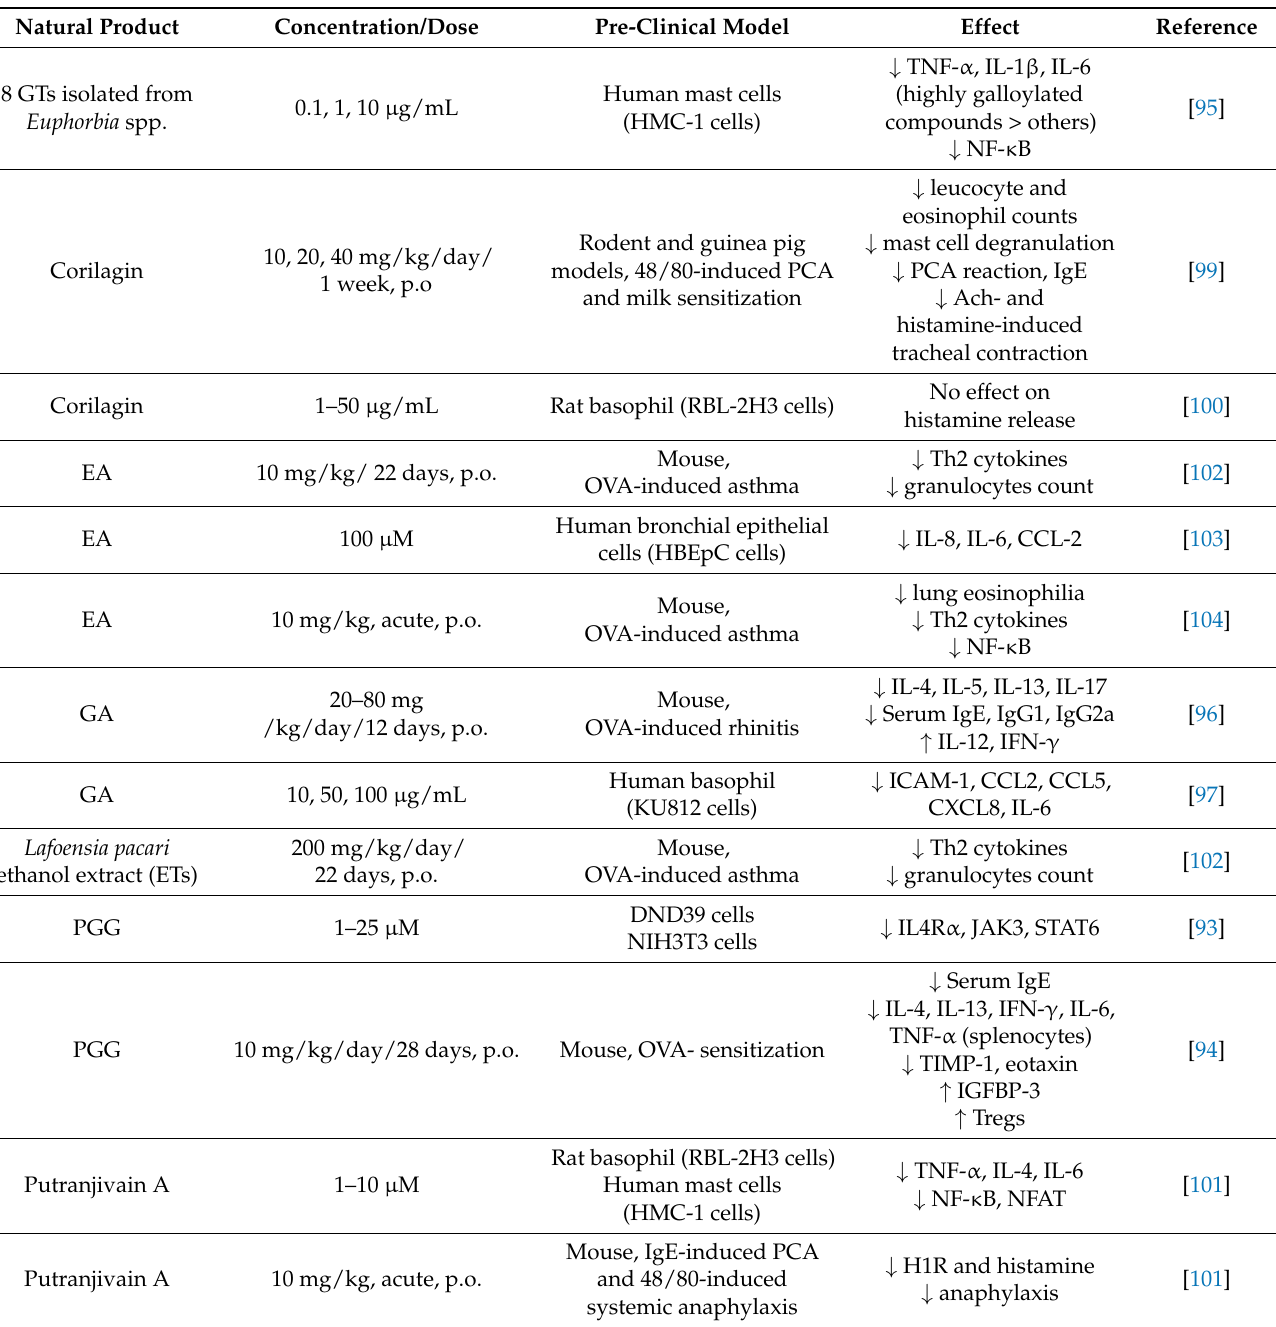
Table 5. Collection of recent articles concerning the biological activity of HTs and their metabolites in asthma and allergic rhinitis